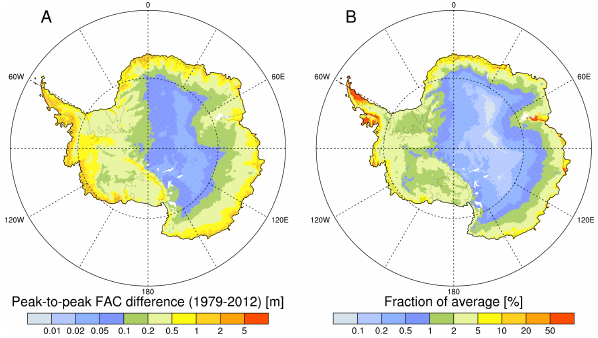
Figure 5. The (a) absolute and (b) relative peak-to-peak variations in firn air content (FAC) in the time-dependent FDM simulation over the 1979–2012 period. The relative difference is compared to the average FAC from Fig.